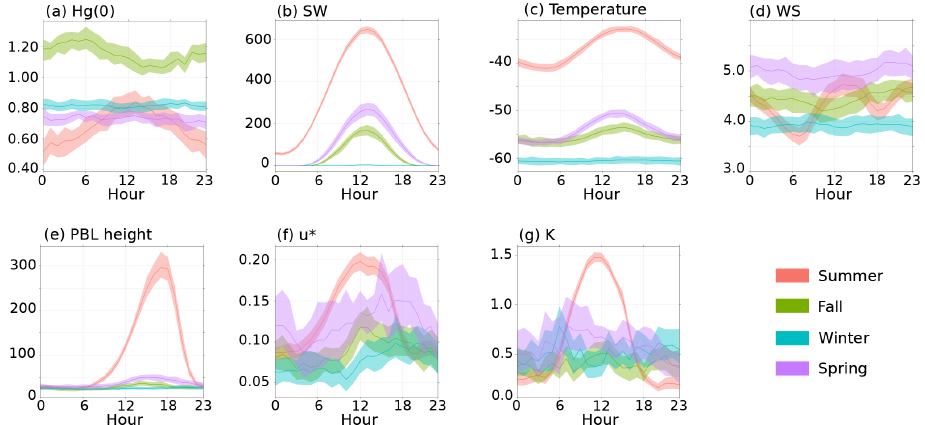
Figure 7. Hourly (local time) mean variation, along with the 95% confidence interval for the mean, of: (a) Hg(0) concentration (in ngm − 3 ) at 25cm above the snow surface, (b) downwelling shortwave (SW) radiation (in Wm − 2 ) according to the MAR model simulations, (c) tem- perature (in ◦ C) at 3m above the snow surface, (d) wind speed at 3m above the snow surface (in m s − 1 ), (e) planetary boundary layer (PBL) height (in m) according to the MAR model simulations, (f) friction velocity ( u ∗ , in ms − 1 ), and (g) Eddy diffusivity ( K , in m 2 s − 1 ) in summer (red), fall (green), winter (blue), and spring (purple). Note that the hourly mean variation of Hg(0) concentration in summer is similar at the three inlets of the meteorological